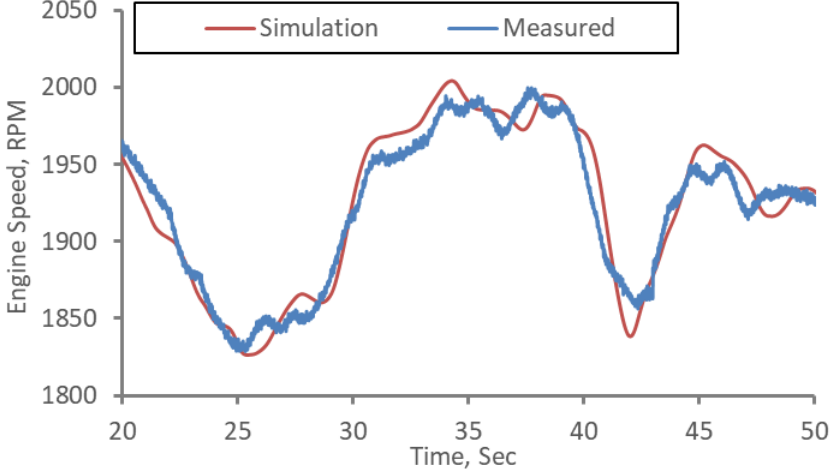
Figure 6. Comparison of simulation and measured engine speeds.